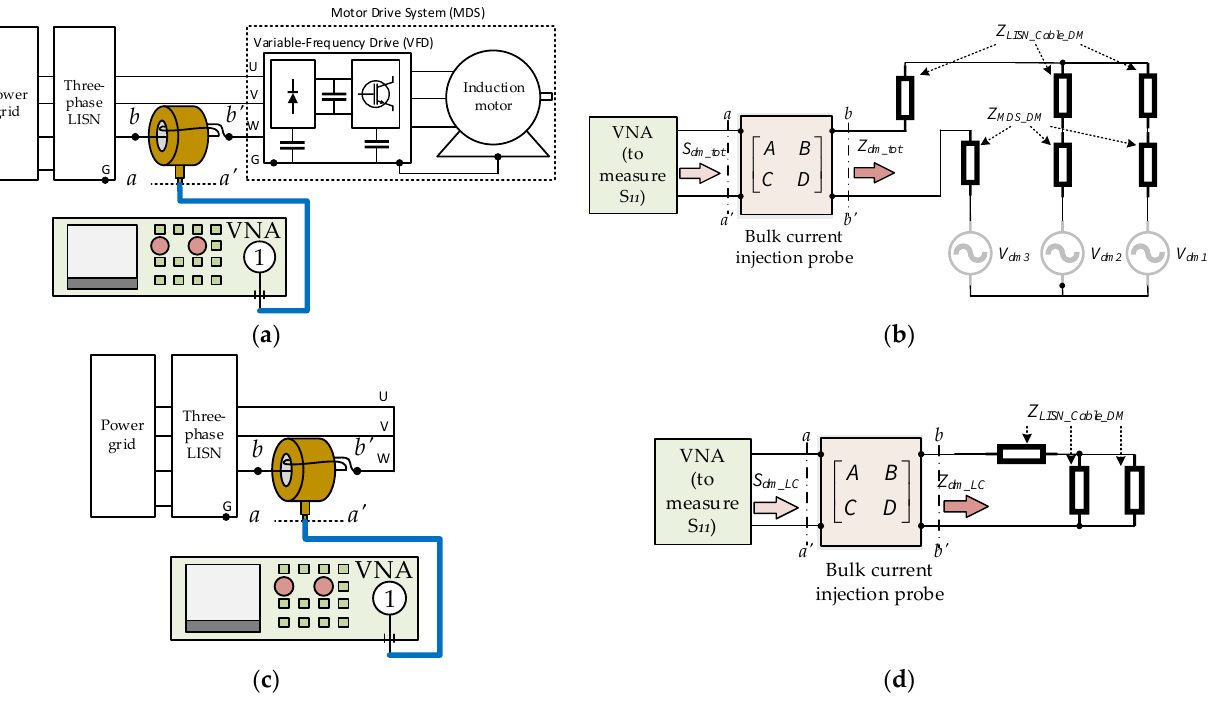
Figure 7. Setups to determine the DM equivalent circuit: ( a , b ) in the presence and ( c , d ) in the absence of the motor drive system.